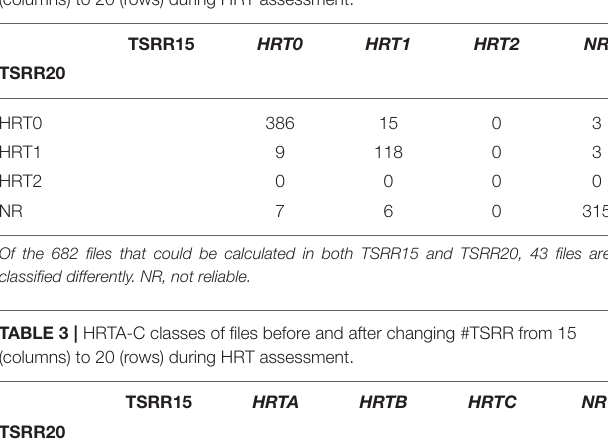
TABLE 2 | HRT0-2 classes of files before and after changing #TSRR from 15 (columns) to 20 (rows) during HRT assessment.